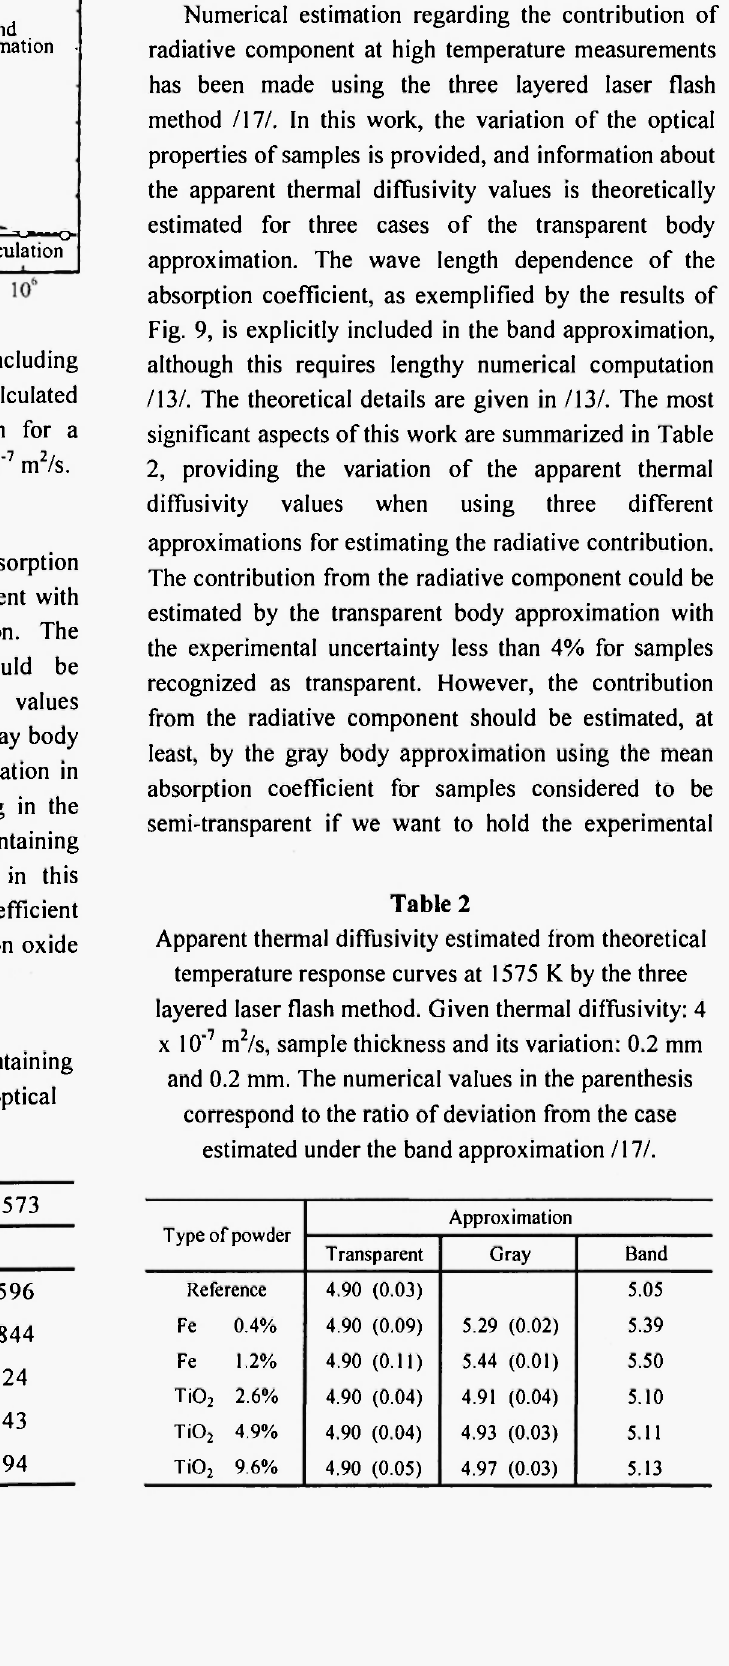
Fig. 11: Apparent thermal diffusivity including radiative heat flow theoretically calculated under the gray body approximation for a sample of thermal diffusivity of 4 χ 10" 7 m 2 /s.